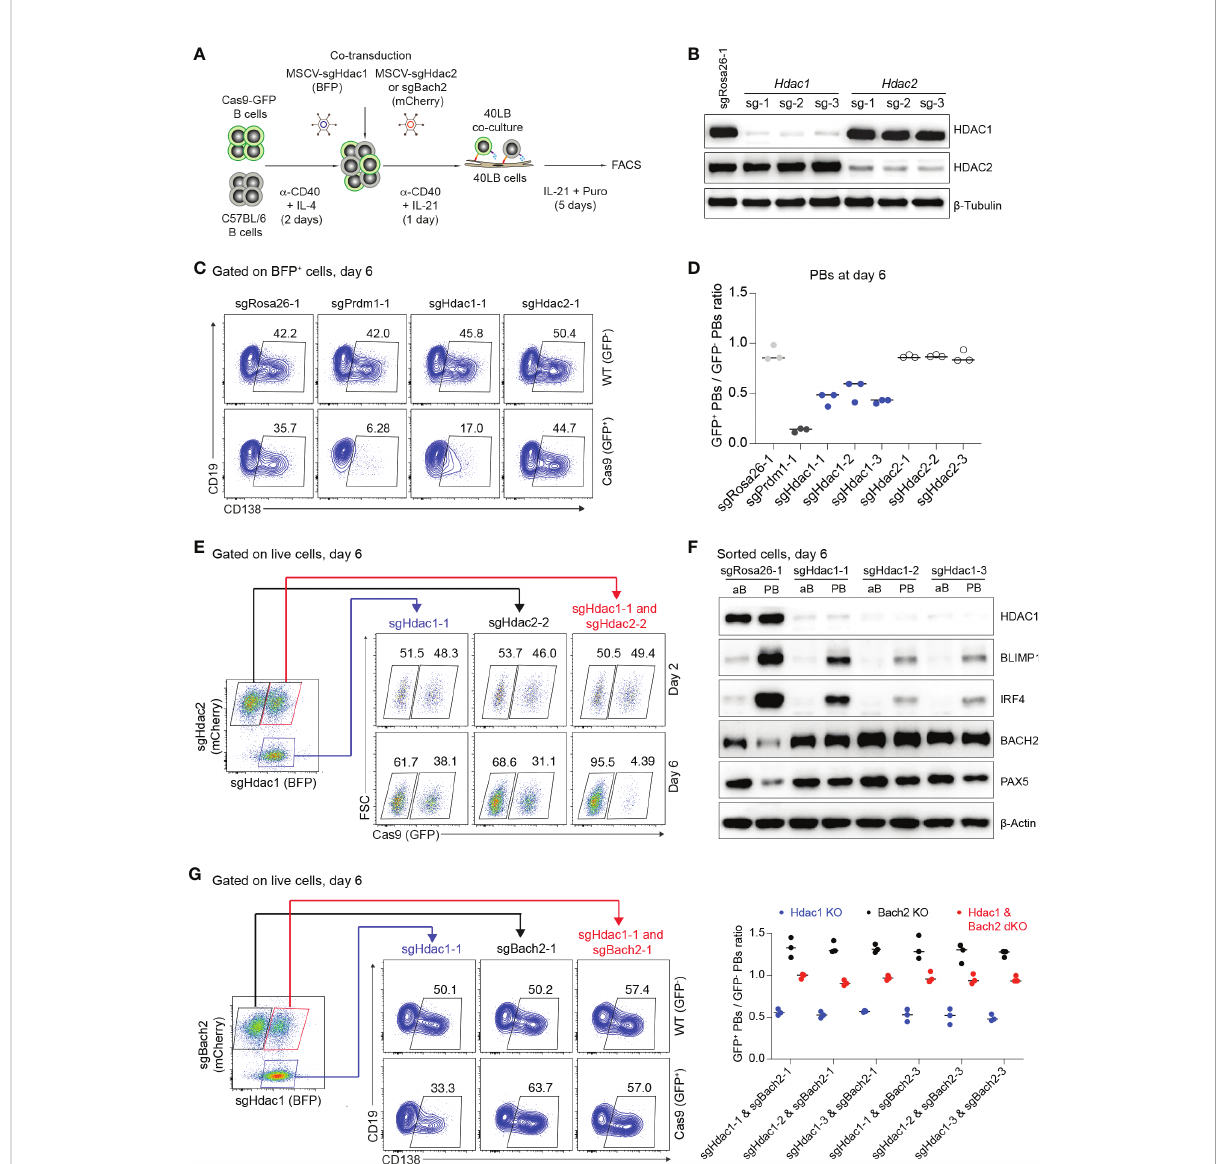
FIGURE 5 Loss of HDAC1 prevents PB differentiation by perturbing the gene regulatory network that speci fi es PB versus B cell fate. (A) Experimental scheme of co-transduction for activated B cells transduced with combinations of retroviral particles expressing Hdac1 -targeting sgRNA (BFP + ) and Hdac2 or Bach2 -targeting sgRNA (mCherry + ). (B) Western blots for HDAC1 and HDAC2 proteins showing gene KO ef fi ciencies of sgRNAs targeting Hdac1 and Hdac2 genes. SgRosa26-1 was used as a negative control. Beta-Tubulin used as a loading control. (C) FACS analysis of one technical repeat experiment at day 6 post transduction showing frequencies of CD138 + PBs in WT (GFP - , top) and Cas9 (GFP + , bottom) cells. (D) Scatter plot showing the ratio of GFP + (Cas9)/GFP - (WT) PBs corresponding to the experiment shown in (C) plus two independent repeat experiments. Each dot corresponds to one independent biological repeat experiment averaged over two technical replicates. (E) FACS analysis of one representative technical replicate of three independent experiments showing frequencies of GFP + B cells in Hdac1 KO (sgHdac1-1, blue), Hdac2 KO (sgHdac2-2, black), or Hdac1 and Hdac2 double KO (dKO) (sgHdac1-1 and sgHdac2-2, red) cell populations in a single culture well, at day 2 and 6 post co-transduction. (F) Western blots showing expression levels of HDAC1, BLIMP1, IRF4, BACH2 and PAX5 transcription factors in sorted CD138 - activated B cells (aB) and CD138 + PBs (PB) treated with indicated sgRNAs. Beta-Actin was used as a loading control. (G) Pre- gating (left) on Hdac1 KO (sgHdac1-1, blue), Bach2 KO (sgBach2-1, black), or Hdac1 and Bach2 dKO (sgHdac1-1 and sgBach2-1, red) cell populations present in a single culture well for the FACS plot (middle) showing frequencies of CD138 + PBs in WT (GFP - , top) and Cas9 (GFP + , bottom) cells in each pre-gated cell population. Scatter plot (right) showing the ratio of GFP + /GFP - PBs corresponding to the experiment shown on the middle (FACS analysis; one technical replicate of three) plus independent biological repeat experiments with different sgRNA combinations (n=3 independent experiments averaged over three technical replicates each; horizontal line indicates